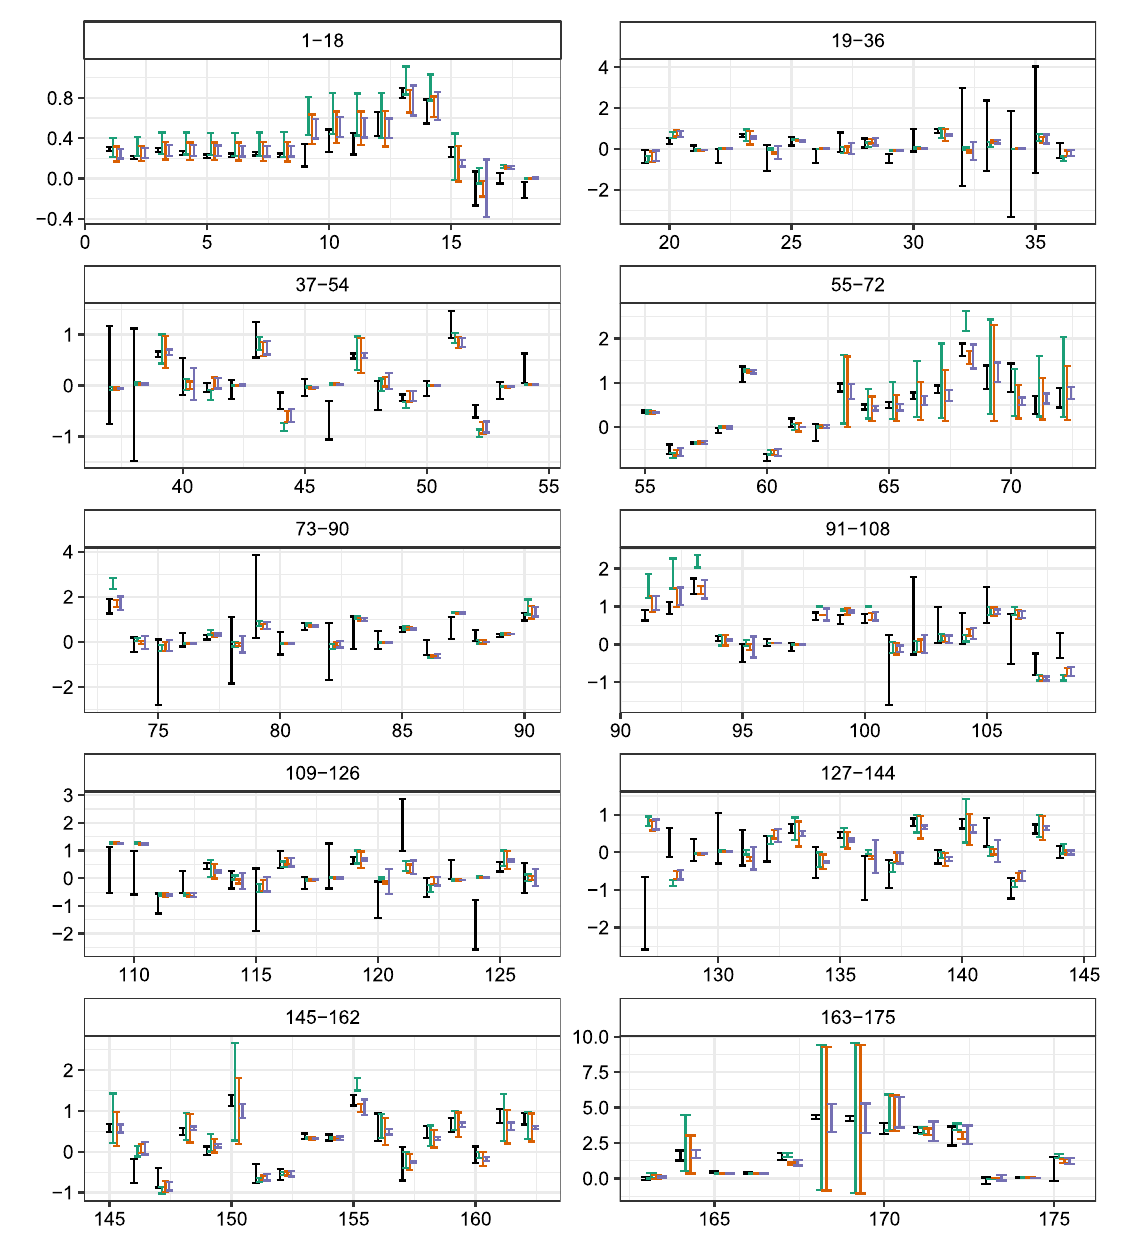
Fig. 6 Measured value (black), SM prediction (green), best fit (brown) and error in the fit (purple) for the 175